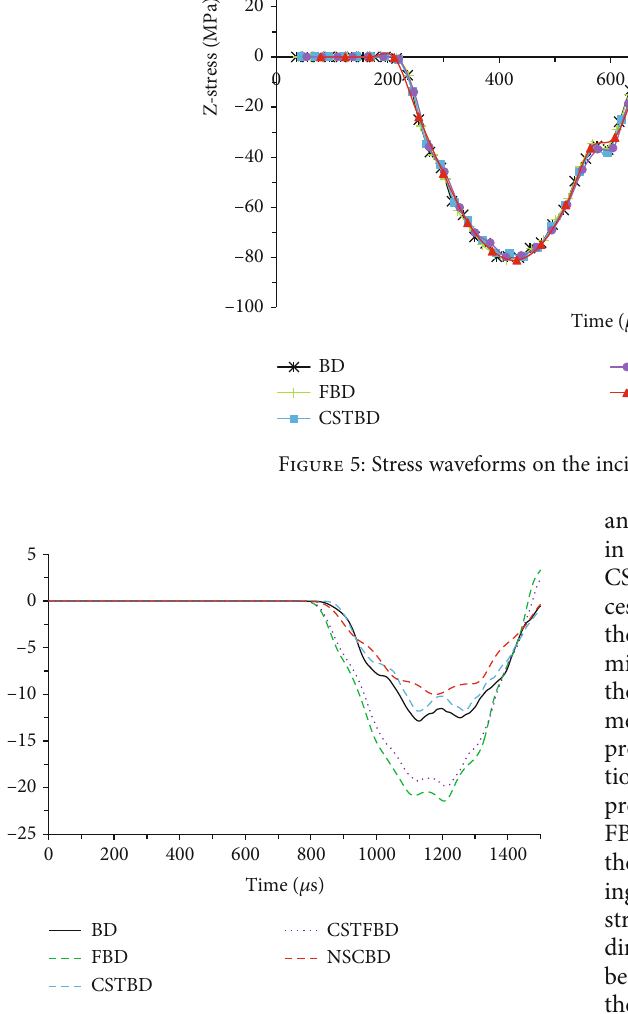
Figure 6: Stress waveform on the transmission bar in di ff erent